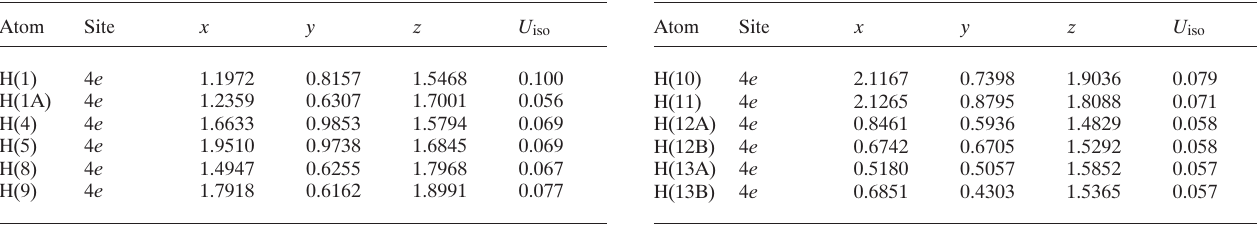
Table 2. Atomic coordinates and displacement parameters (in Å 2 )